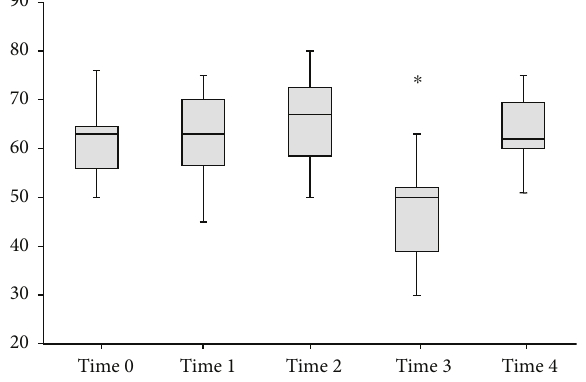
Figure 3: Left ventricle ejection fraction measured by transesophageal echocardiography. Box and whisker diagram of left ventricle ejection fraction expressed in %. Whisker extremities are maximum and minimum, boxes are interquartile ranges between the 75th and 25th percentiles, and the segment inside the box is the median of the sample. P value < 0.001 results from a Friedman ’ s two-way analysis of variance by rank. The ∗